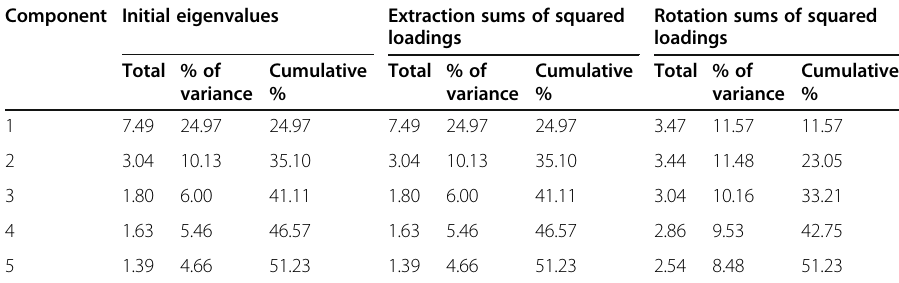
Table 3 Total variance explained Component Initial eigenvalues Extraction sums of squared